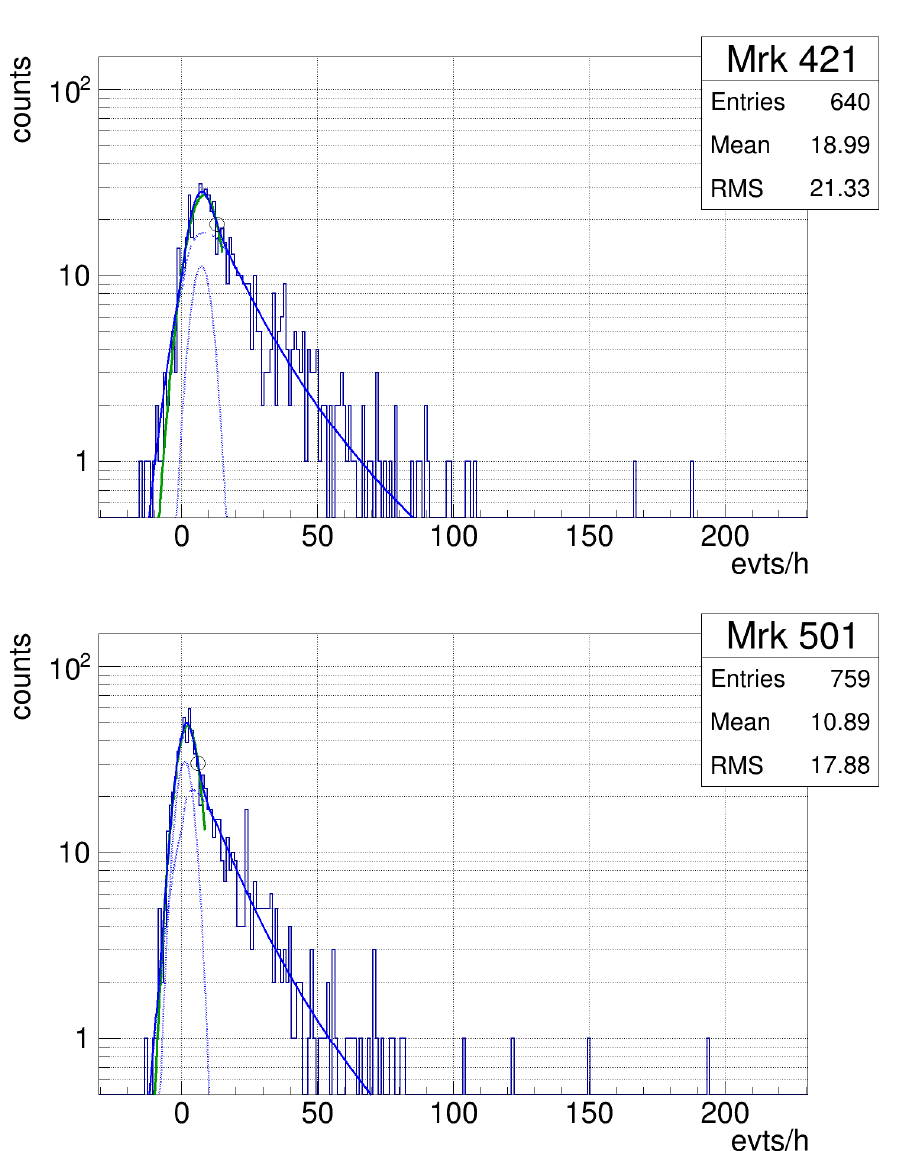
Figure 2. Distributions of nightly fluxes of Mrk 421 (top) and Mrk501 (bottom), as measured by FACT. In blue, the fit of the sum of a Gaussian and log-normal distribution is shown indicating in addition the two components as dashed blue lines. The fit of a Gaussian to the main part of the peak is shown in green. The crossing point of the two fits is marked with a